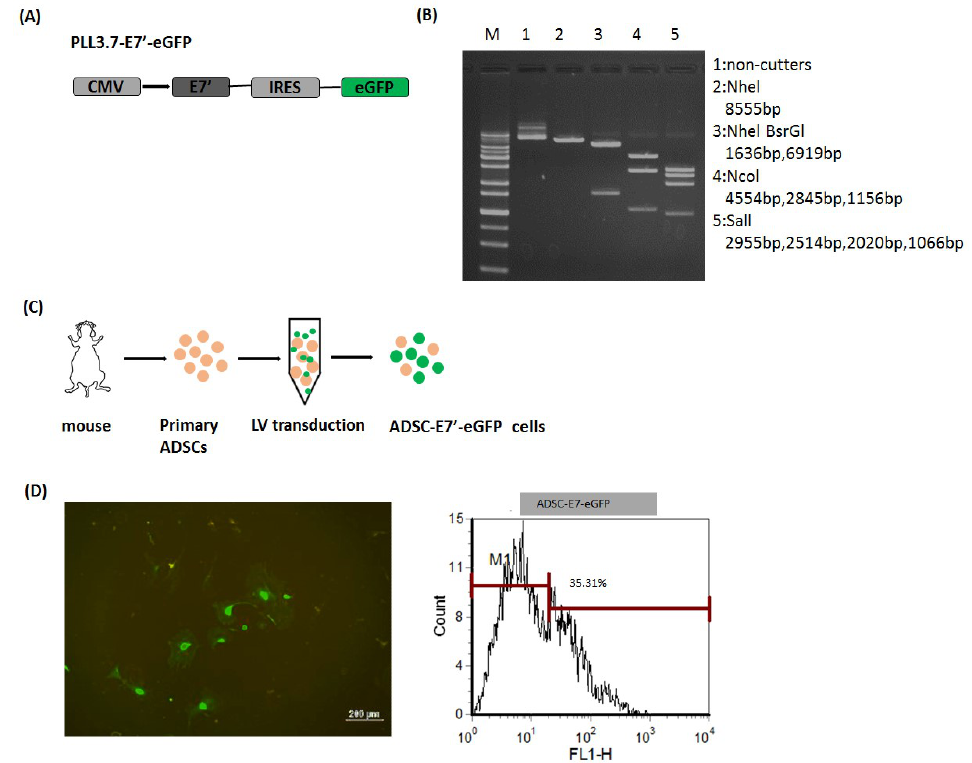
Figure 1. Establishment of ADSC labeled with enhanced green fluorescent protein (eGFP) and combined with modified E7’ (ADSC-E7’-eGFP). ( A ) Schematic diagram of pLL3.7-E7’-eGFP construction; ( B ) agarose gel electrophoresis of plasmid pLL3.7-E7’-eGFP (M: 1 kb DNA ladder; lane 1: Undigested plasmid; lane 2: uNheI (8555 bp); lane 3: NheI and BsrGI (1636 bp and 6919 bp); lane 4: ( C ) illustration of lentiviral transduction of primary ADSCs; and ( D ) fluorescence microscopy and flow cytometric analysis of ADSC-E7’-eGFP